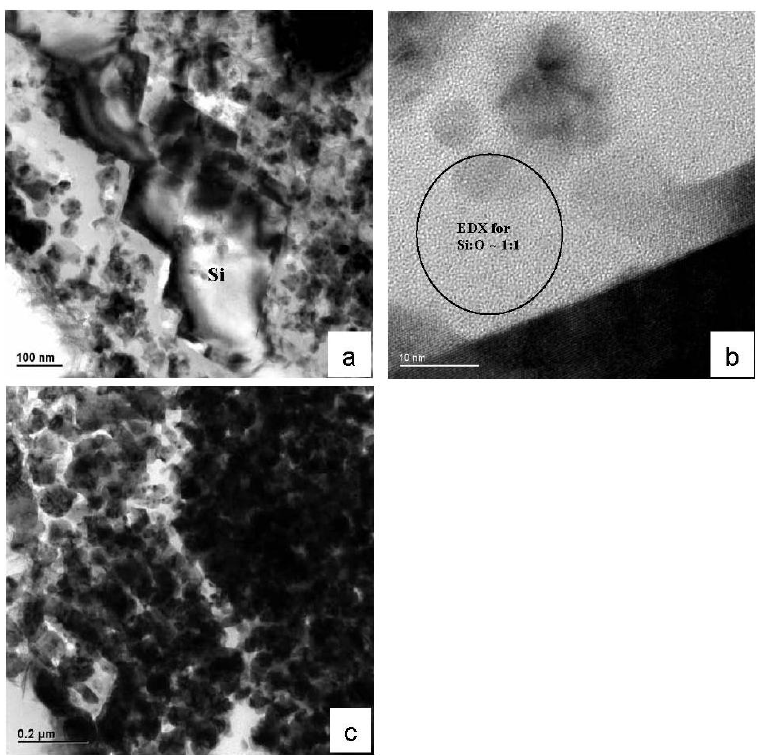
Figure 7. (a) TEM micrograph of the displacement reaction, Ni deposits, Si sidewall and the interface with (111) Si microfacets; (b) High-mag TEM micrograph of the reaction interface, with brightly-contrasted phase identified by EDX as Si:O ~1; (c) TEM micrograph of pore sidewall showing the consumption of Si and full deposition of